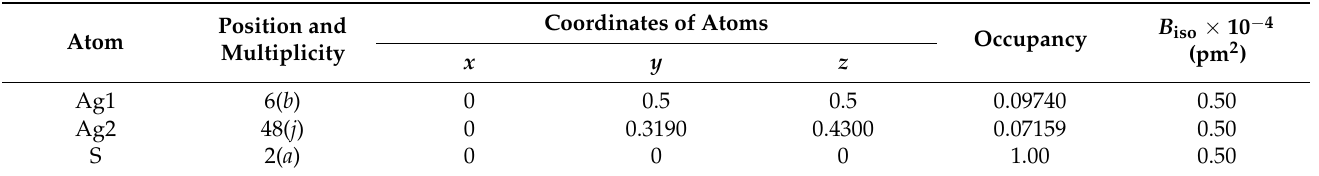
Table 2. Refined crystal structure of bcc (space group Im 3 m ( O 9 sulfide with β -Ag 2 S argentite structure at 443 K: Z = 2, a = b = c = 0.4859(3)